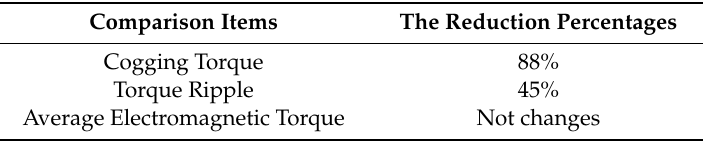
Table 3. Comparison of torque before and after Table 1. Comparison of torque before and after optimization.